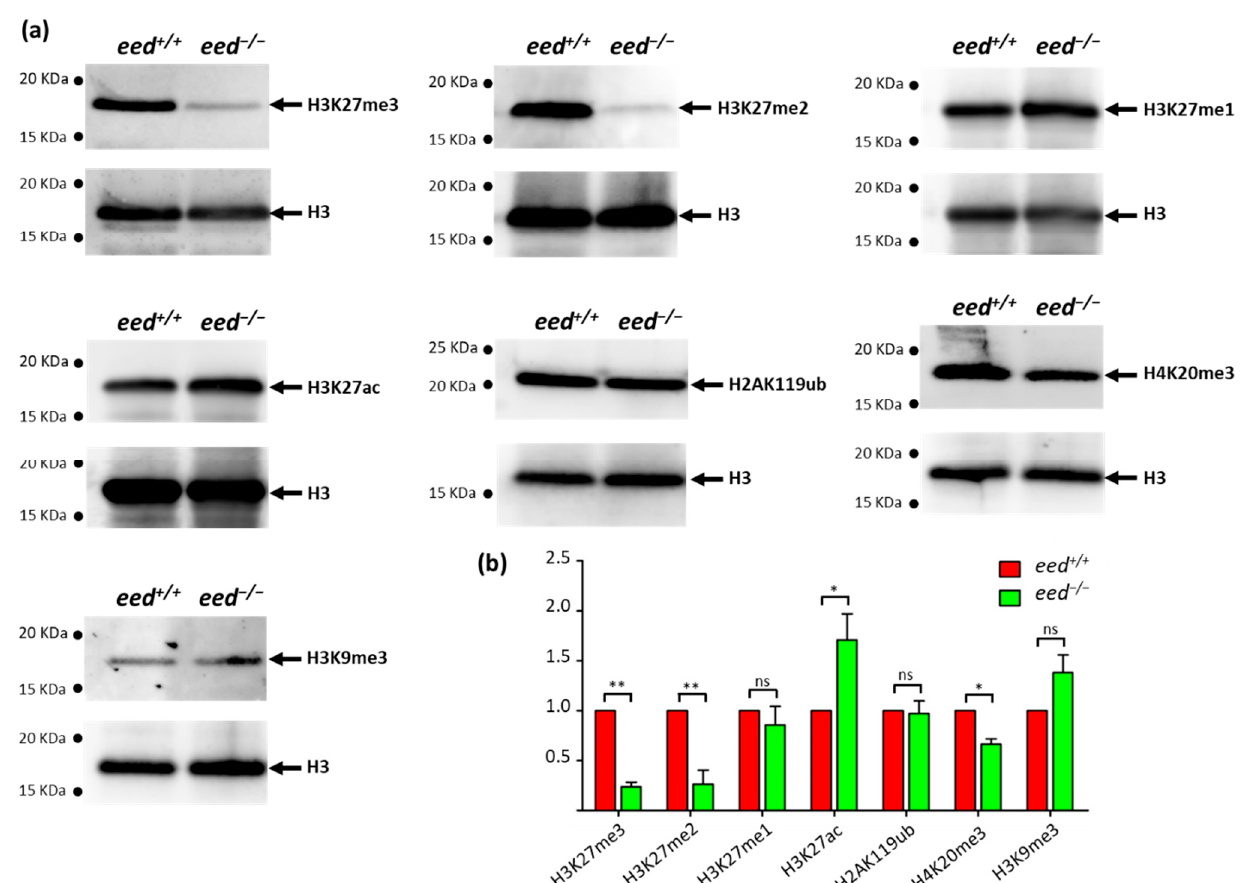
Figure 3. Effects of eed loss of function on global levels of histone modifications: ( a ) after genotyping of the caudal extremity of larvae, 10 to 15 µ g of bulk histones from a pool of 10 eed +/+ or eed − / − siblings at 9 dpf were analyzed by Western blot using specific antibodies recognizing H3K27me3, H3K27me2, H3K27me1, H2AK119ub, H3K27ac, H3K9me3 or H4K20me3. After stripping, the membranes were reprobed with an anti-histone H3 as a control; ( b ) comparison between eed +/+ (red) and eed − / − (green) siblings, of histone modification signals normalized by total histone H3 and expressed relative to the levels found in the wild-type fish. Quantified levels are the mean ± SD of at least three independent histone extractions, except for H3K9me3, where two histone extraction were performed, followed by Western blot analysis. Statistical significance was assessed using a Student t ‐ test; ns, non ‐ significant; *, p < 0.05; **, p < 0.01. (See Supplementary Materials).